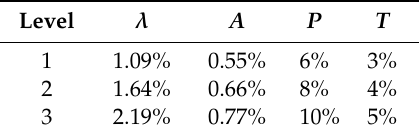
Table 2. Non-dimensional values of wavelength, amplitude, position, and